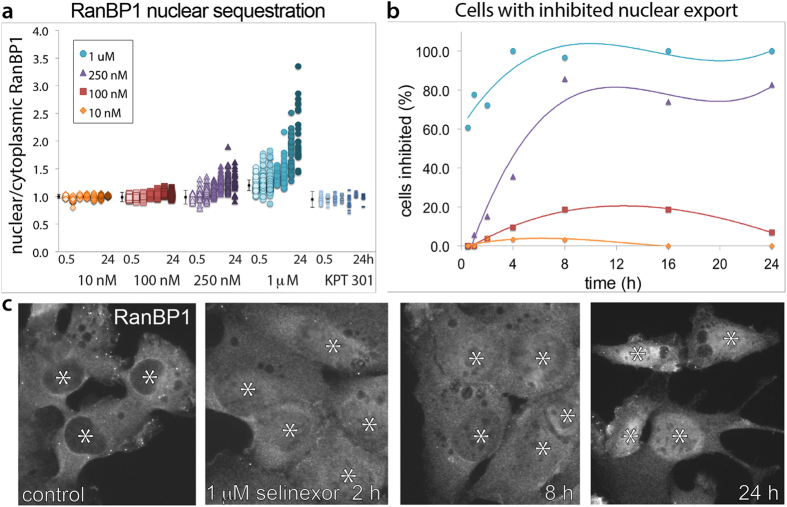
Selinexor causes rapid and persistent inhibition of nuclear export.(a) Scatter plot showing normalized (control) nuclear/cytoplasmic RanBP1 ratios in HT1080 cells for different selinexor concentrations. Cells were treated for: 0.5, 1, 2, 4, 8, 16 and 24 h. Error bars show the control average +/− two standard deviations for each experiment. Increased nuclear/cytoplasmic ratios are concentration and time-dependent. (b) Percent of HT1080 cells showing nuclear export inhibition after selinexor is concentration dependent. A cell is inhibited if its average nuclear/cytoplasmic RanBP1 ratio exceeds the average ratio in control cells by at least two standard deviations. Control uses an inactive SINE stereoisomer termed KPT 301. (c) RanBP1 staining in HT1080 cells for control and 2, 8, and 24 h. RanBP1 is rapidly sequestered and accumulates in the nucleus over time. Bar is 10 μm. Over 100 cells were measured for each condition.